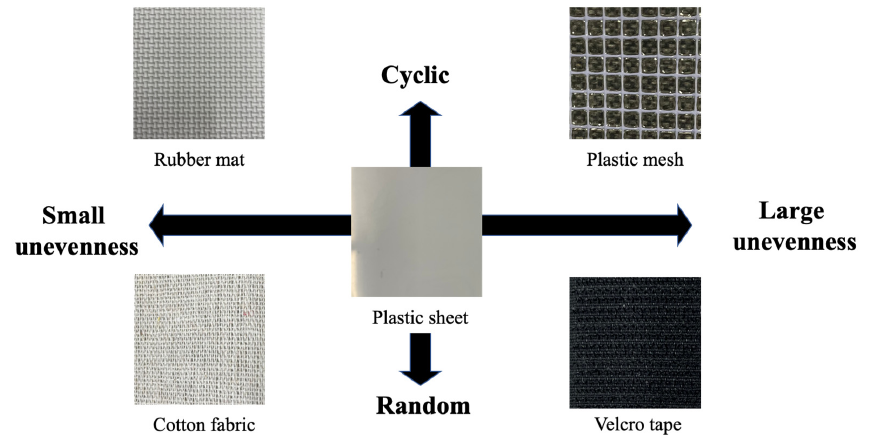
Figure 9. Selected five materials with different textures.